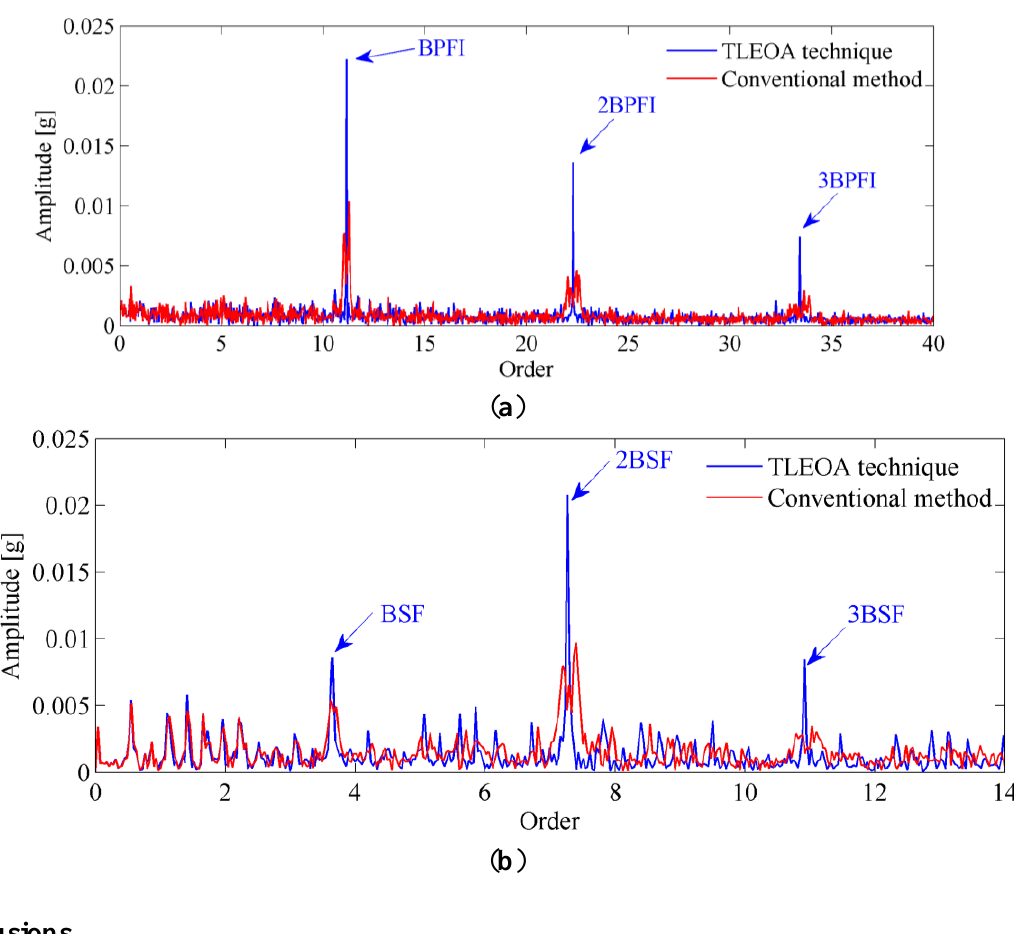
Figure 19. Comparison with conventional method: ( a ) Inner race fault detection; ( b ) Roller fault